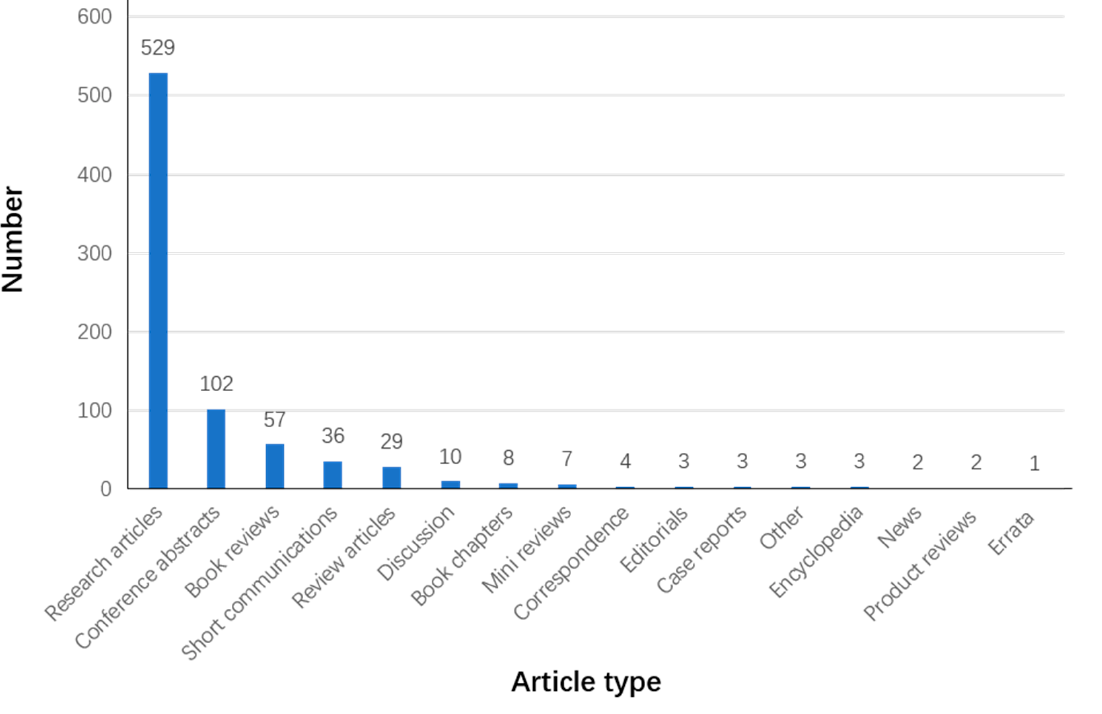
Figure 4. The number of different AT article types in ScienceDirect (devised by the authors).